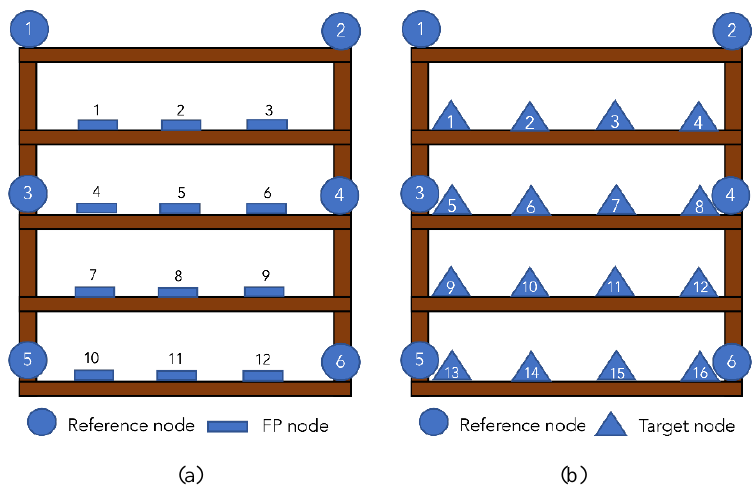
Figure 11. The illustration of a 3D environment in a bookshelf, a) fingerprint position and b) target position.